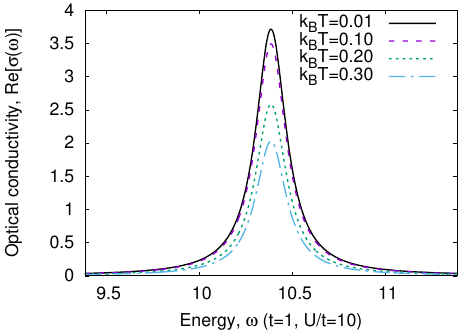
Figure 3. Optical conductivity Re σ ( ω + i 0, T ) (20) for the model (9).